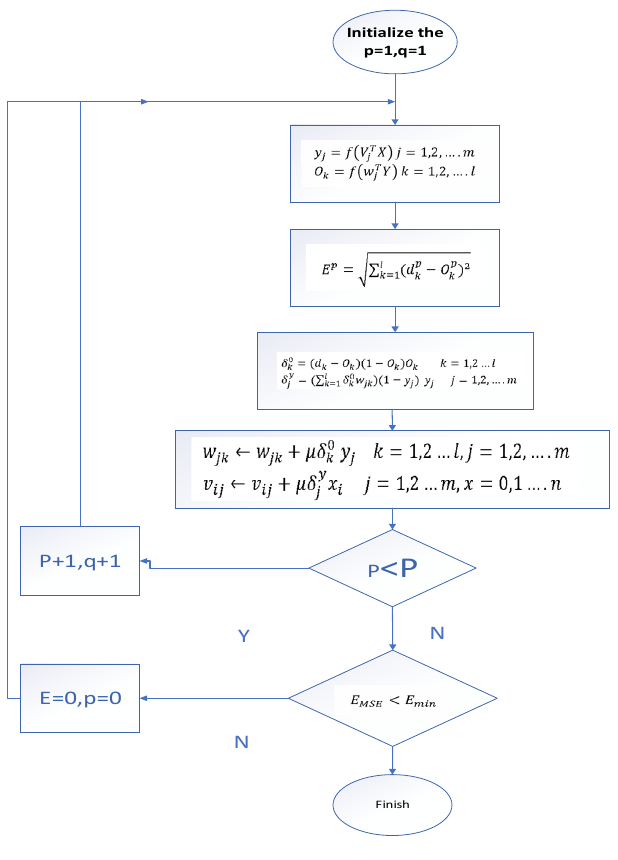
Figure 4. Model flow chart. Based on the actual production data of steelmaking, an artificial neural network model was established to predict the end point content of EAF steelmaking. The neural network model was trained with 800 times of heating data, the neural network model was tested with 200 times of heating data, and the neural network model was verified with 200 times of heating data.The model test results are shown in Figures 5 and 6.